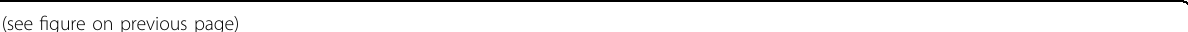
Fig. 2 NOX4 is responsible for TGF- β downregulation-induced ROS generation. a A375 and HPAC cells were infected with adenovirus expressing shTGF- β 1 or - β 2 at 100 MOI, respectively. After 48 h, the expression levels of NOX1, NOX4, 5-lipoxygenase, and GAPDH were detected by western blot analysis. b A375 and HPAC cells were infected with adenovirus expressing shTGF- β 1 or transfected with pCMV6-myr-Akt or infected with adenovirus expressing shTGF- β 1 and subsequently transfected with pCMV6-myr-Akt. After 48 h, NOX4, phospho-Akt, Akt, and GAPDH were detected by western blot analysis. c Expression levels of NOX4 mRNA in A375 and HPAC cells were assayed by quantitative real-time polymerase chain reaction (qRT-PCR). d A375 cells were infected with adenovirus expressing shTGF- β 1. After 6 h, infected cells were treated with NAC (10 mM) for 42 h, and then the expression of NOX4 and GAPDH was detected by western blot analysis. e A375 cells were infected with adenovirus expressing shTGF- β 1 at 100 MOI, and after 6 h, infected cells were treated with p38 inhibitor (SB203580, 10 μ M) or JNK inhibitor (SP600125, 10 μ M) or both for 42 h. Then the expression of NOX4 and GAPDH was detected by western blot analysis. f A375 cells were infected with adenovirus expressing shTGF- β 1 at 100 MOI or adenovirus expressing shTGF- β 1 followed by NAC (10 mM) or adenovirus expressing shTGF- β 1 followed by p38 inhibitor (SB203580, 10 μ M) or adenovirus expressing shTGF- β 1 followed by transfection with pCMV6-myr-Akt or adenovirus expressing shTGF- β 1 followed by transfection with siRNA of Smad4 based on the siRNA transfection protocol (Santa Cruz, CA, USA). After 48 h, the expression levels of NOX4 mRNA were assayed by quantitative real-time polymerase chain reaction (qRT-PCR). Error bars represent the standard error from three independent experiments. Asterisks indicate a signi fi cant difference compared to each given control (* p < 0.05; ** p < 0.01). g A375 cells were infected with adenovirus expressing shTGF- β 1 at 100 MOI or adenovirus expressing shTGF- β 1 followed by transfection with siRNA of Smad4. After 48 h, NOX4 and GAPDH were detected by western blot analysis. h A375 cells were infected with adenovirus expressing shTGF- β 1 at 100 MOI or adenovirus expressing shTGF- β 1 followed by transfection with siRNA of NOX4 based on the siRNA transfection protocol (Santa Cruz, CA, USA). After 48 h, cell viability was tested via an MTS viability assay (upper left), or cells were incubated with DCF-DA (20 μ M, 1 h) for the detection of ROS using a fl uorescent reader and microscopy (upper right, lower left) or the expression levels of various ER stress markers; in addition, PARP, p-ASK1, ASK1, p-p38, p38, p-JNK, and JNK were detected by western blot analysis (right). i A375 cells were infected with adenovirus expressing shTGF- β 1 at 100 MOI or adenovirus expressing shTGF- β 1 followed by treatment with NOX4 inhibitor (GKT137831, 140 nM). After 48 h, cell viability was tested via an MTS viability assay (upper left), or cells were incubated with DCF-DA (20 μ M, 1 h) for the detection of ROS using a fl uorescent reader and microscopy (upper right, lower left) or the expression levels of various ER stress markers; in addition, PARP, p-ASK1, ASK1, p-p38, p38, p-JNK, and JNK were detected by western blot analysis (right). j A375 cells were infected with adenovirus expressing shTGF- β 1 at 100 MOI or adenovirus expressing shTGF- β 1 followed by transfection with siRNA of NOX4 or NOX1 based on the siRNA transfection protocol (Santa Cruz, CA, USA). After 48 h, cell viability was tested via an MTS viability assay (upper left), or cells were incubated with DCF-DA (20 μ M, 1 h) for the detection of ROS using a fl uorescent reader and microscopy (upper right, lower left) or the expression levels of various ER stress markers; in addition, PARP, p-ASK1, ASK1, p-p38, p38, p-JNK, and JNK were detected by western blot analysis